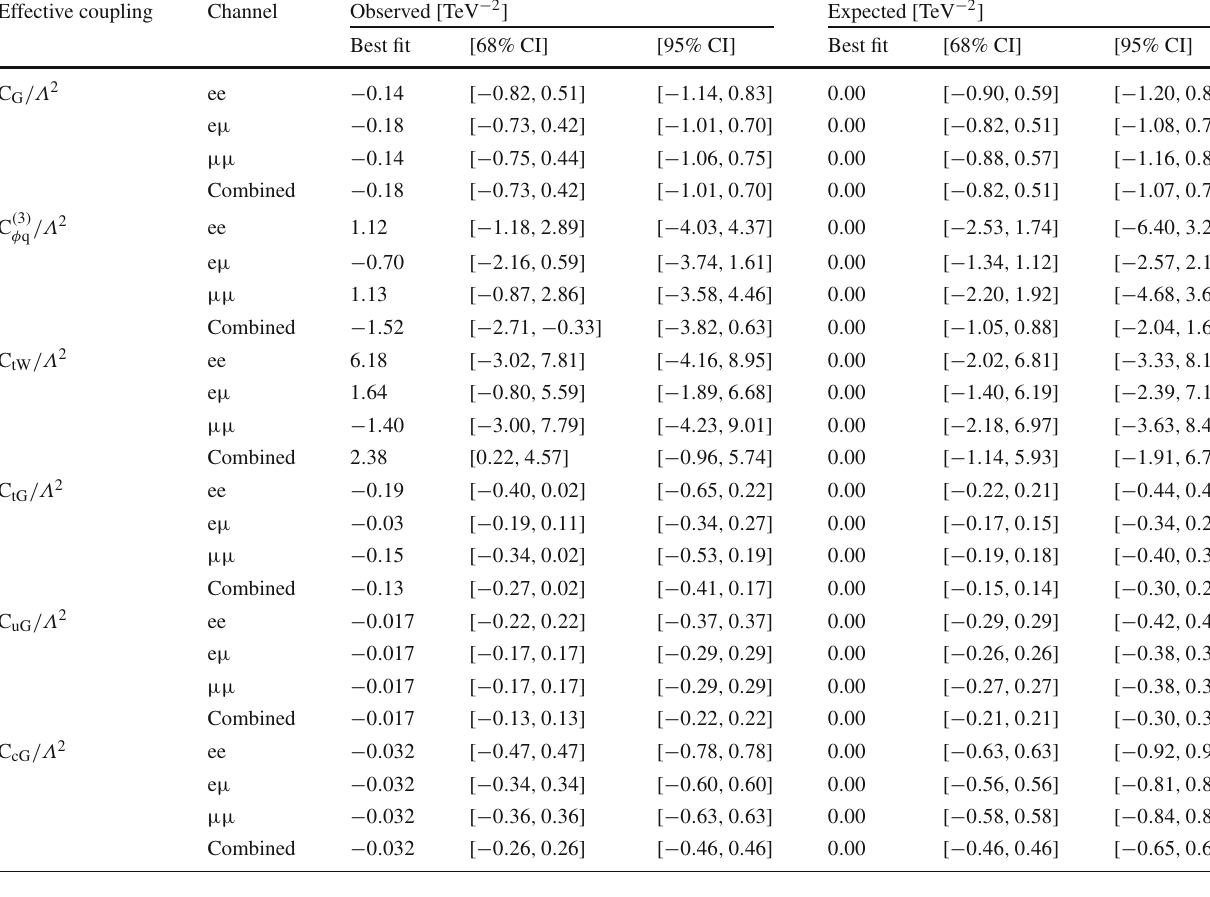
Sect. 5, are taken into account with the exception of the uncertainties on the SM cross section predictions for the tt and tW processes